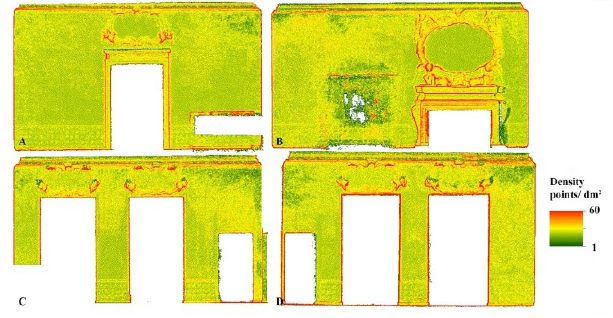
Figure 6. Map of point density distribution (10 dm2) for 4 analysed